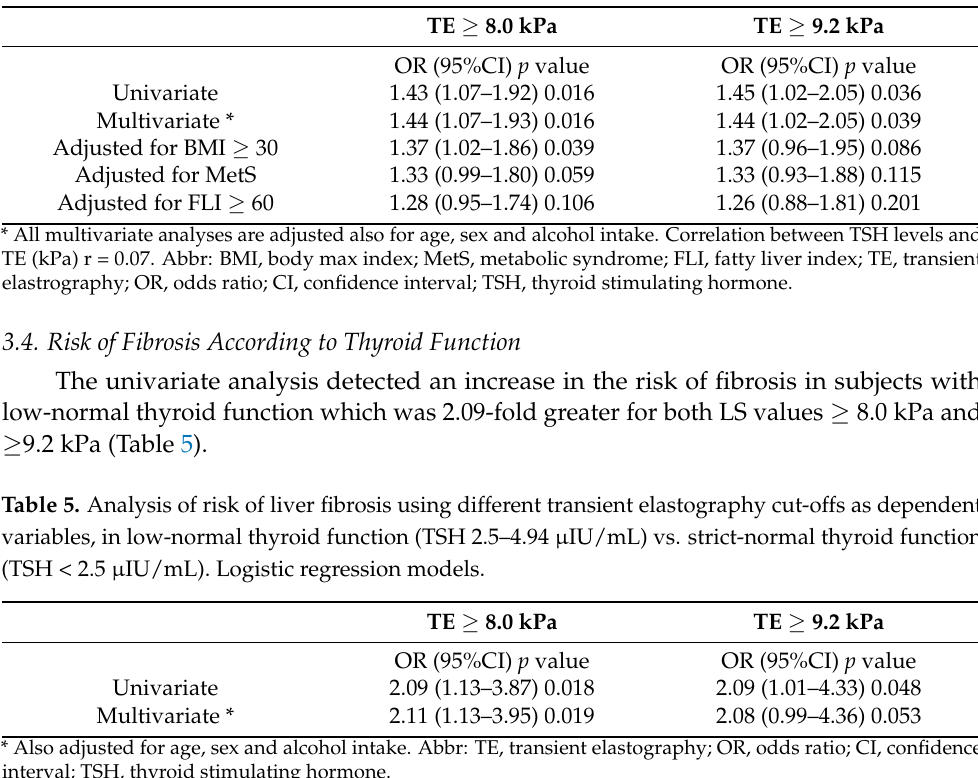
Table 4. Analysis between TSH levels ( µ IU/mL) and risk of liver fibrosis, using different transient elastography cut-offs as dependent variables. Logistic regression models.